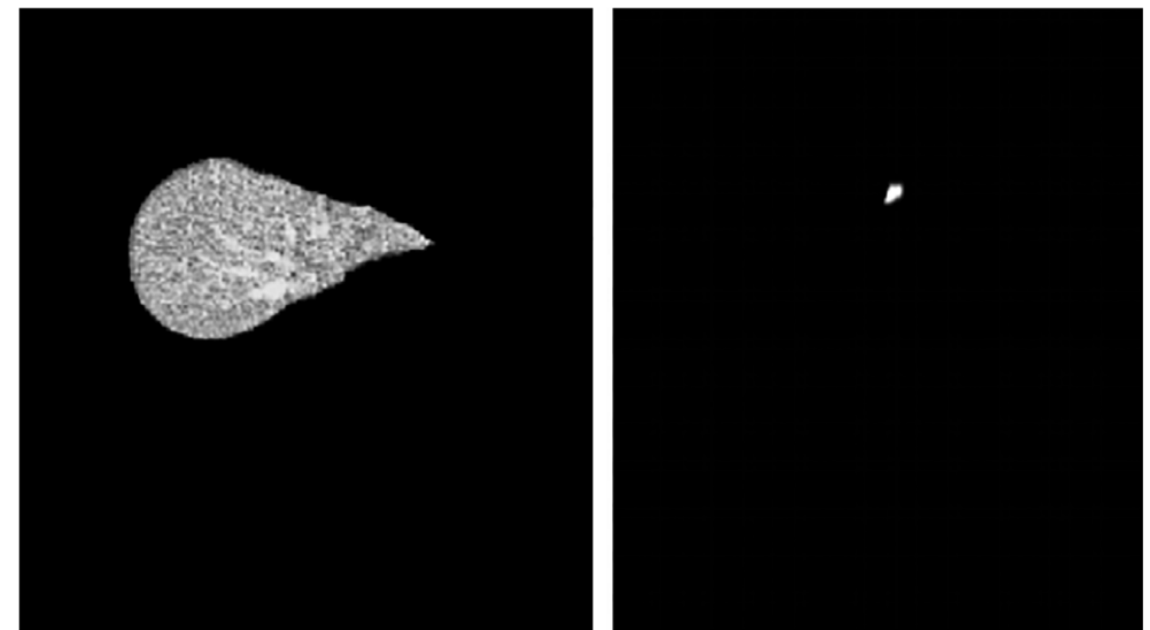
Figure 2. A sample image with a very minute tumour (not visible for the human eye) and its mask.